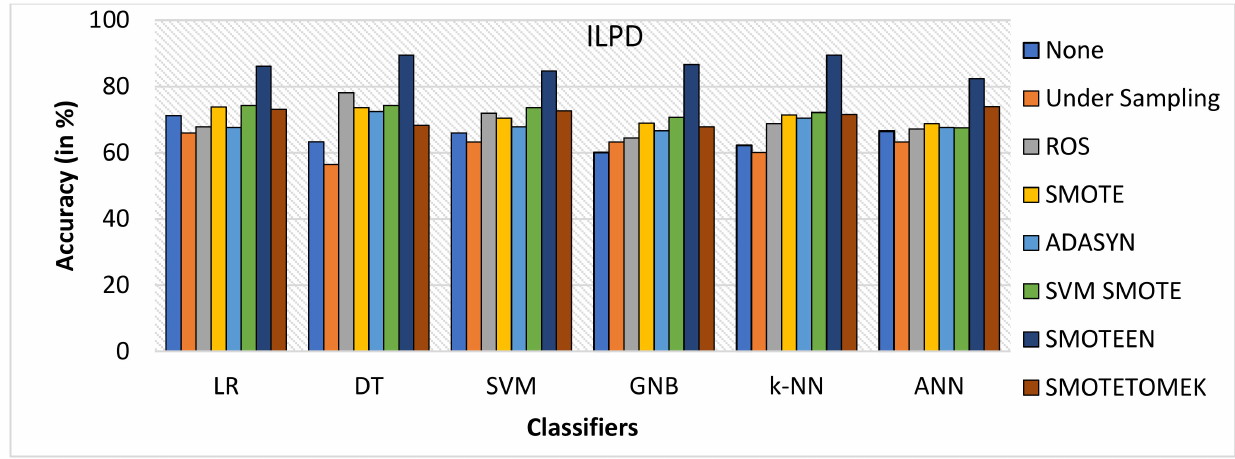
Figure 10. Accuracy for ILPD dataset of balancing algorithms over six classifiers.